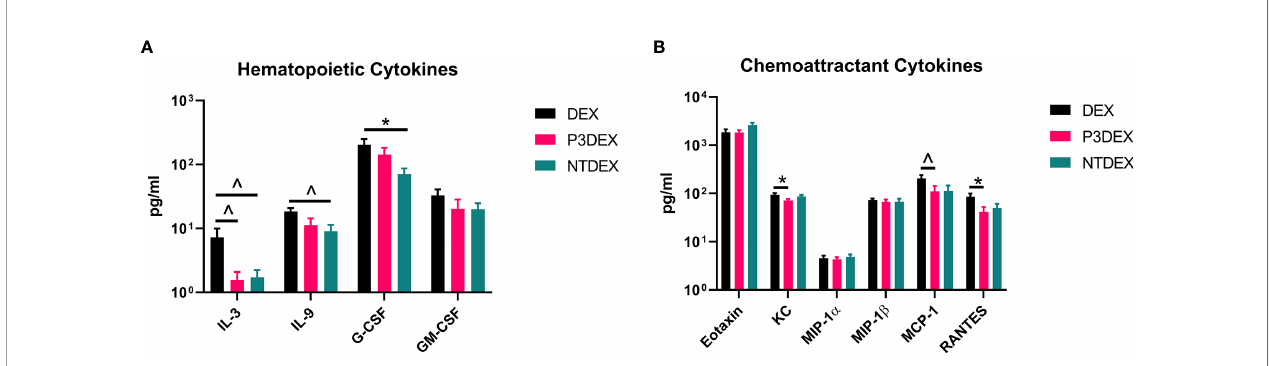
FIGURE 3 | LNFPIII and LNnT conjugates alter hematopoietic and chemoattractant signals. Measurements of (A) hematopoietic and (B) chemoattractant cytokines are shown here in response to DEX, P3DEX, or NTDEX treatment. One-way ANOVA with Dunnett ’ s Multiple Comparisons Test. *indicates a signi fi cant difference (p ≤ 0.05). ^indicates a trend (p ≤ 0.10).